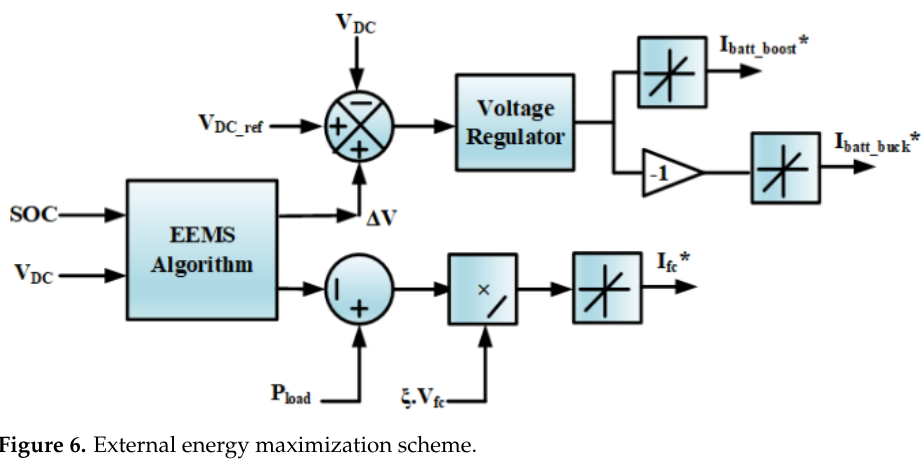
Figure 6. External energy maximization scheme.